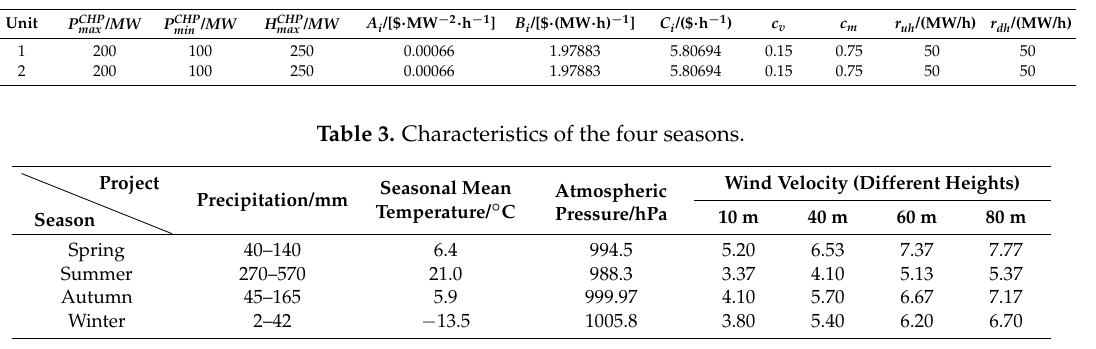
Table 2. Parameters of CHP unit.